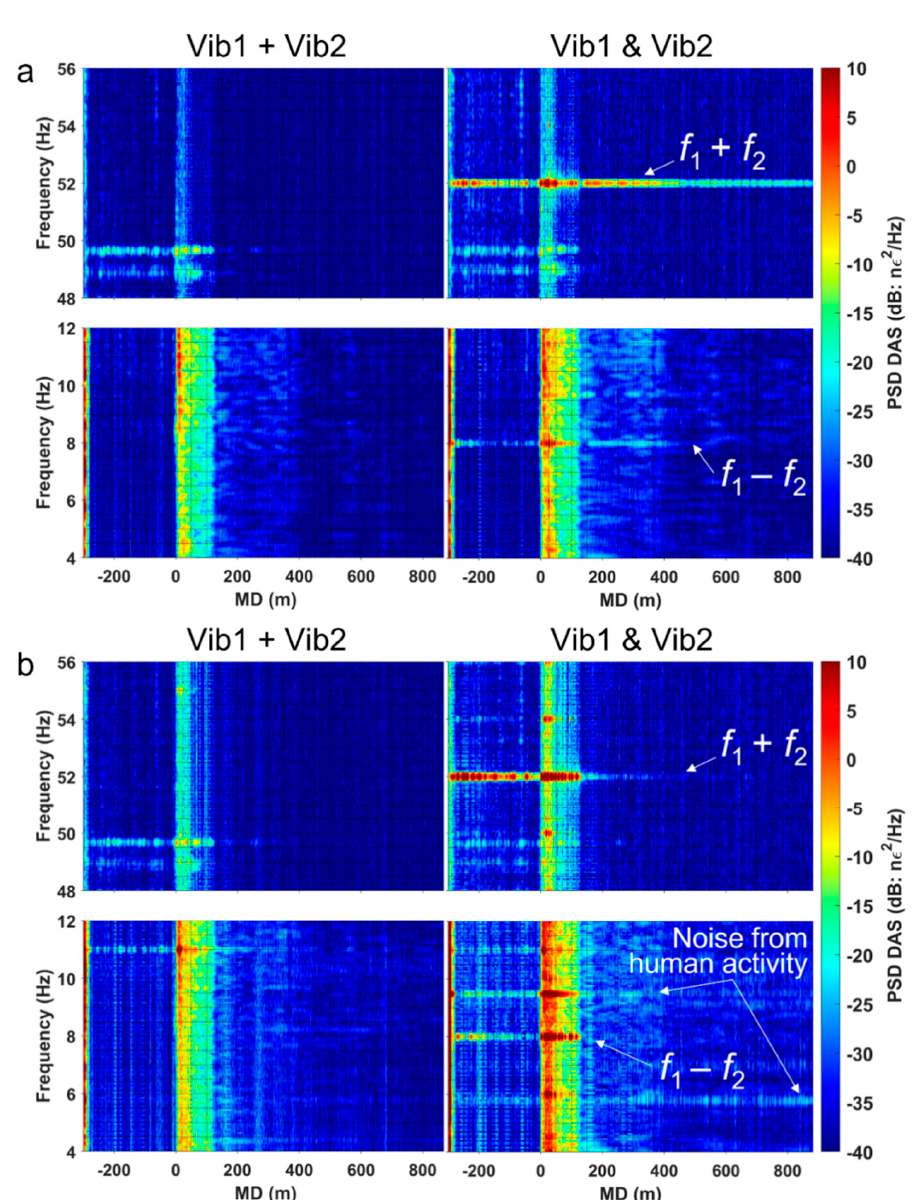
Figure 4. Spectrograms of the recorded data during ( a ) nearfield test and ( b ) far-field test zoomed in around combinational frequencies of 8 Hz and 52 Hz. Images in the left column show the spectrogram of the linear superposition of the data recorded when the vibrators were working solo; images in the right column show the spectrogram of data recorded when two vibrators were working simultaneously. The measured depth (MD) starts at the wellhead and its negative values correspond to the part of the cable coiled around the well on the surface.